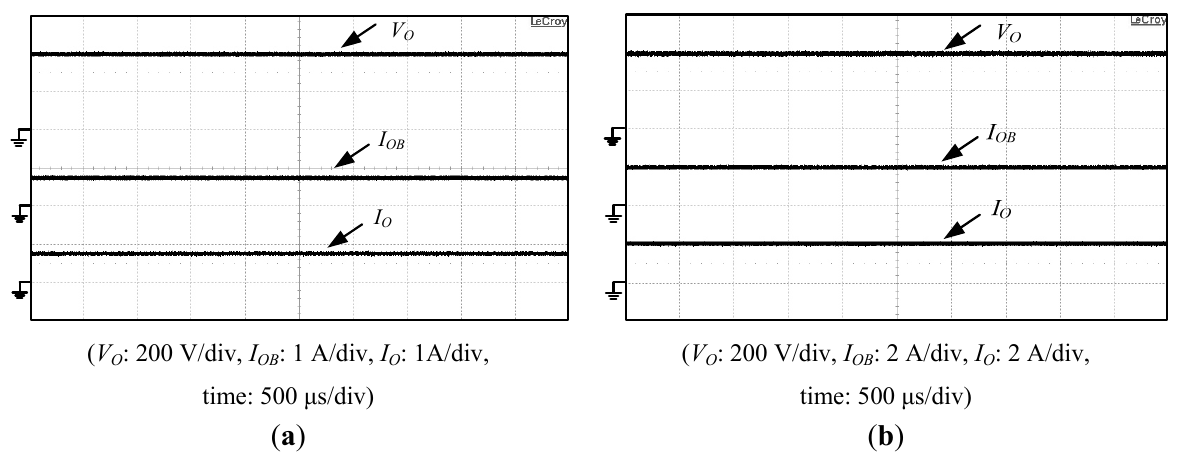
, current I and I waveforms of the proposed PV power O OB O = 320 W; and ( b ) under P L